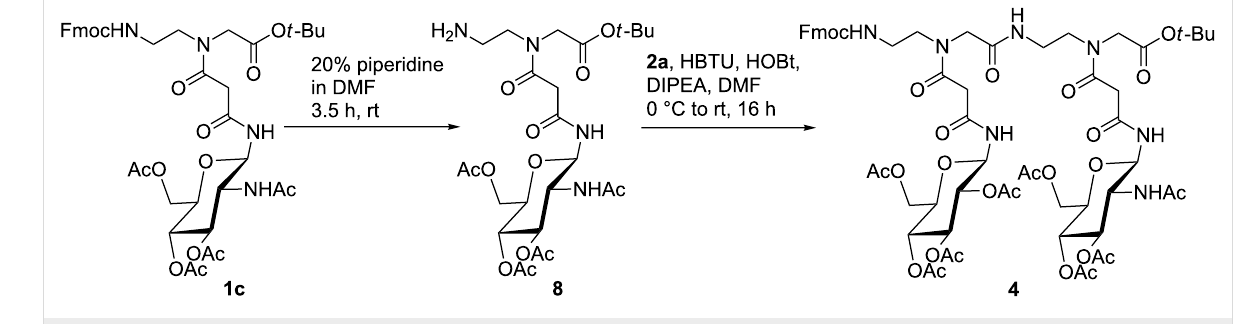
Scheme 3: Synthesis of the dimeric glycoconjugate 4 .